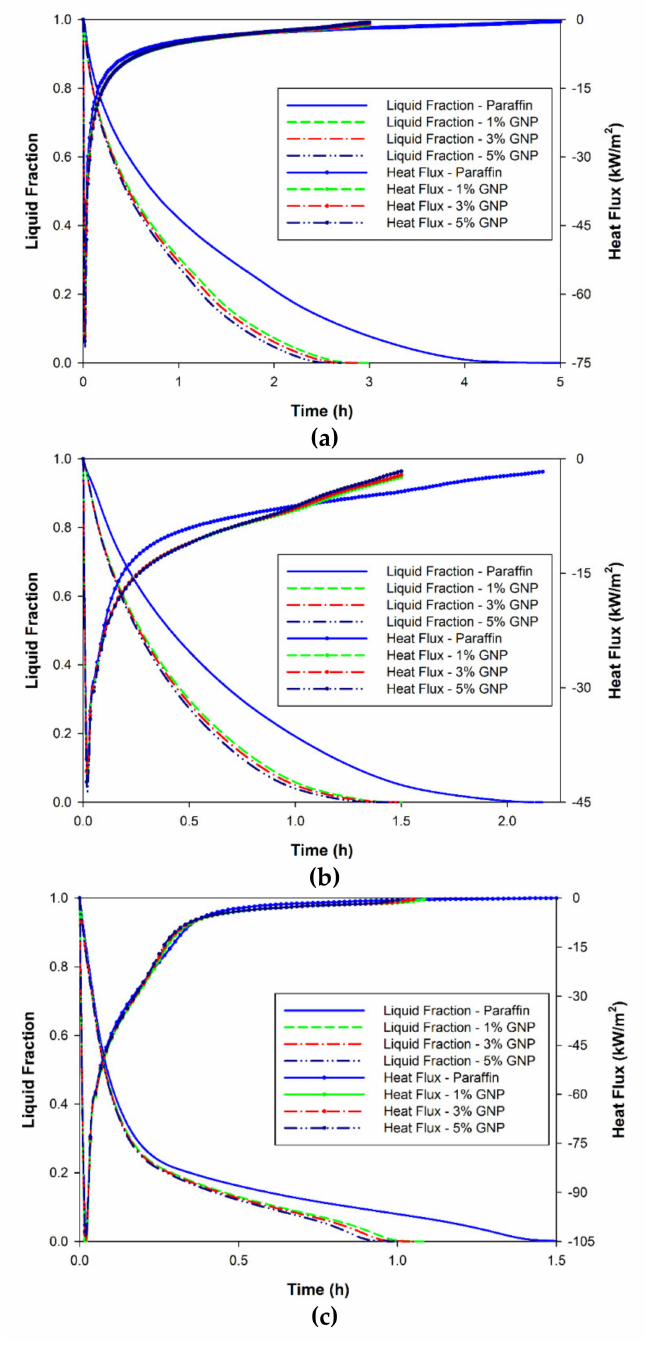
Figure 7. Transient heat flux and liquid fraction performance of paraffin and nano-PCMs while discharging in shell-and-tube with: ( a ) longitudinal, ( b ) radial and ( c ) wire-wound